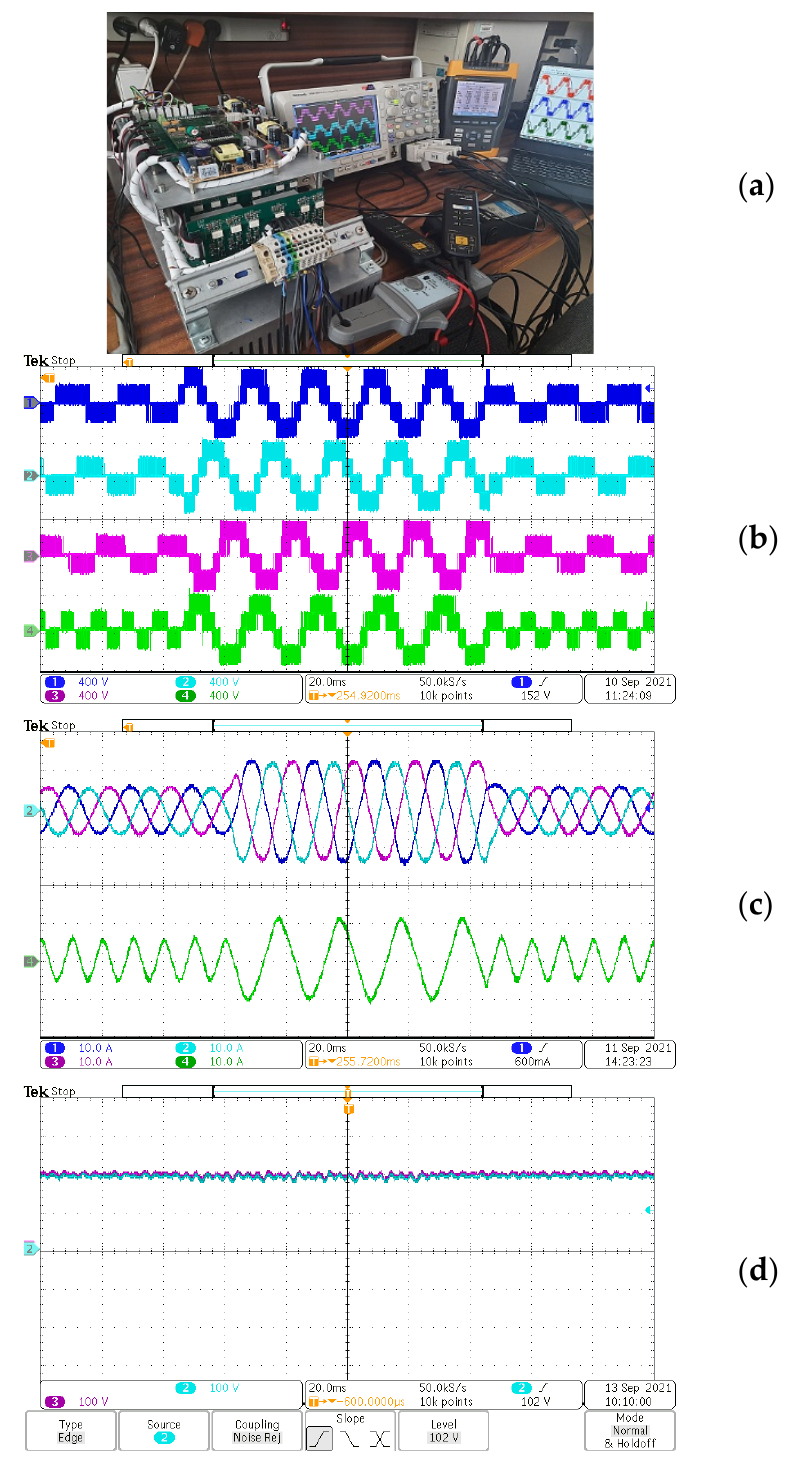
Figure 9. Prototype setup, experimental output voltage and current waveforms of the dual-phase inverter for common and different frequency operations, and capacitor-bank voltages. ( a ) Inverter prototype setup; ( b , c ) output voltages and current waveforms for common-frequency (50 Hz) opera- tion and different modulation indices of 1.1547 and 1, and for the common modulation index (0.7559) and different 50 and 100 Hz frequency operations for inverters 1 and 2; ( d ) corresponding capacitor banks’ voltage waveforms.